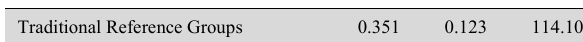
Simple regression test results for the second hypothesis Variable R R² F Sig F β T Sig T Hypothesis Decision Traditional Reference Groups 0.351 0.123 114.103